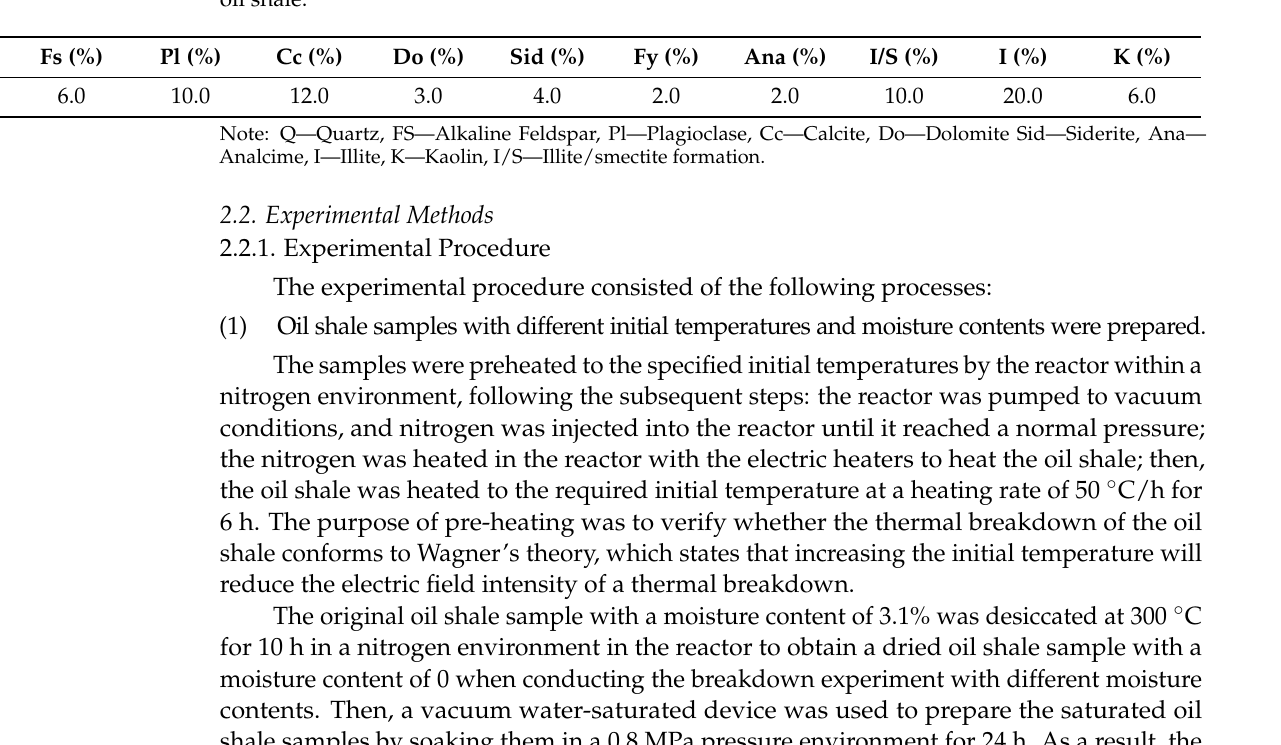
Table 4. Relative content of the mineral components determined by the X-diffraction for Huadian oil